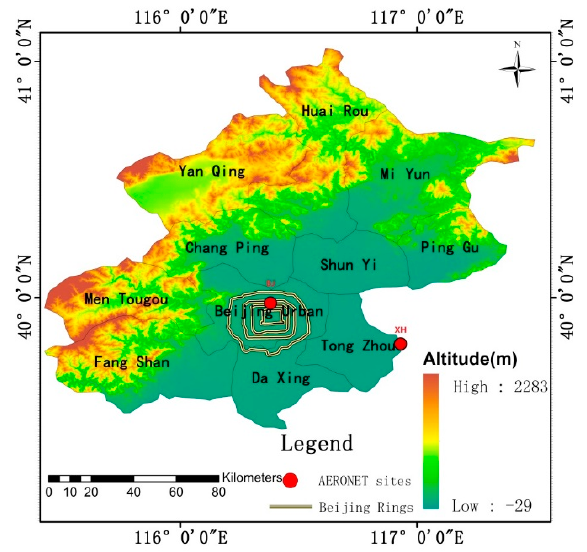
Figure 1. AERONET sites in Beijing.